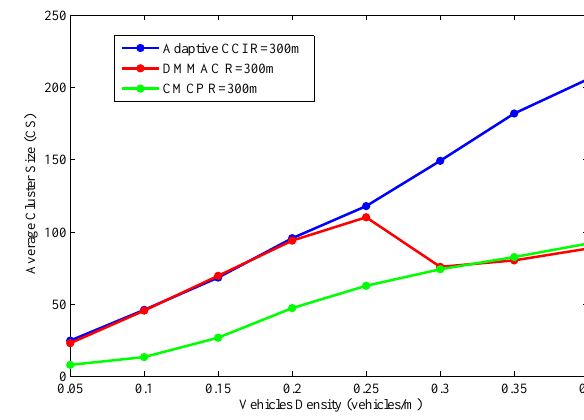
Figure 4. Packet delay versus vehicle’s density